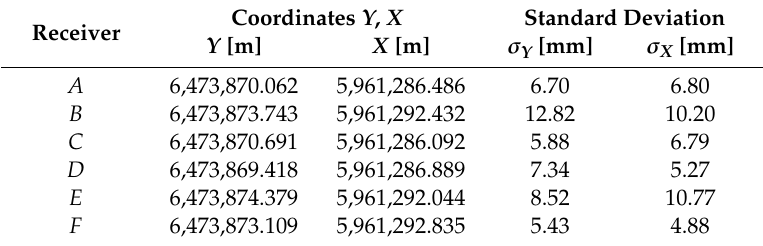
Table 1. Position coordinates of GNSS receivers determined for stationary measurements.